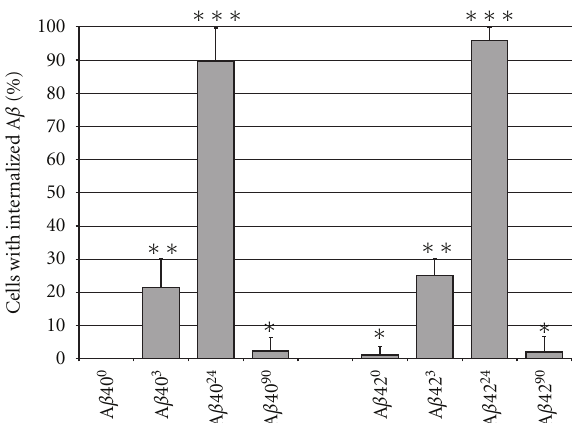
Figure 6: Percentage of PC12 cells with internalized A β . A β 40 24 and A β 42 24 were more significantly internalized into di ff erentiated PC12 cells than the other forms of A β . A β 40 90 and A β 42 90 display a striking drop in the amount of internalization. Error bars represent the standard deviation from at least three individual experiments with n > 200 cells per condition. Statistical significance is indicated ( ∗ ) P < . 005.